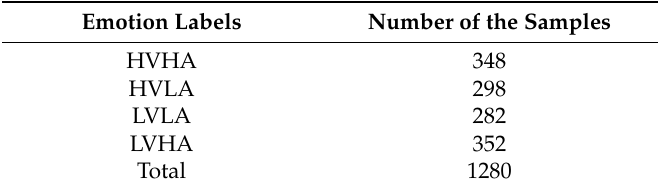
Table 3. The number of samples in different emotion classifications 1 .